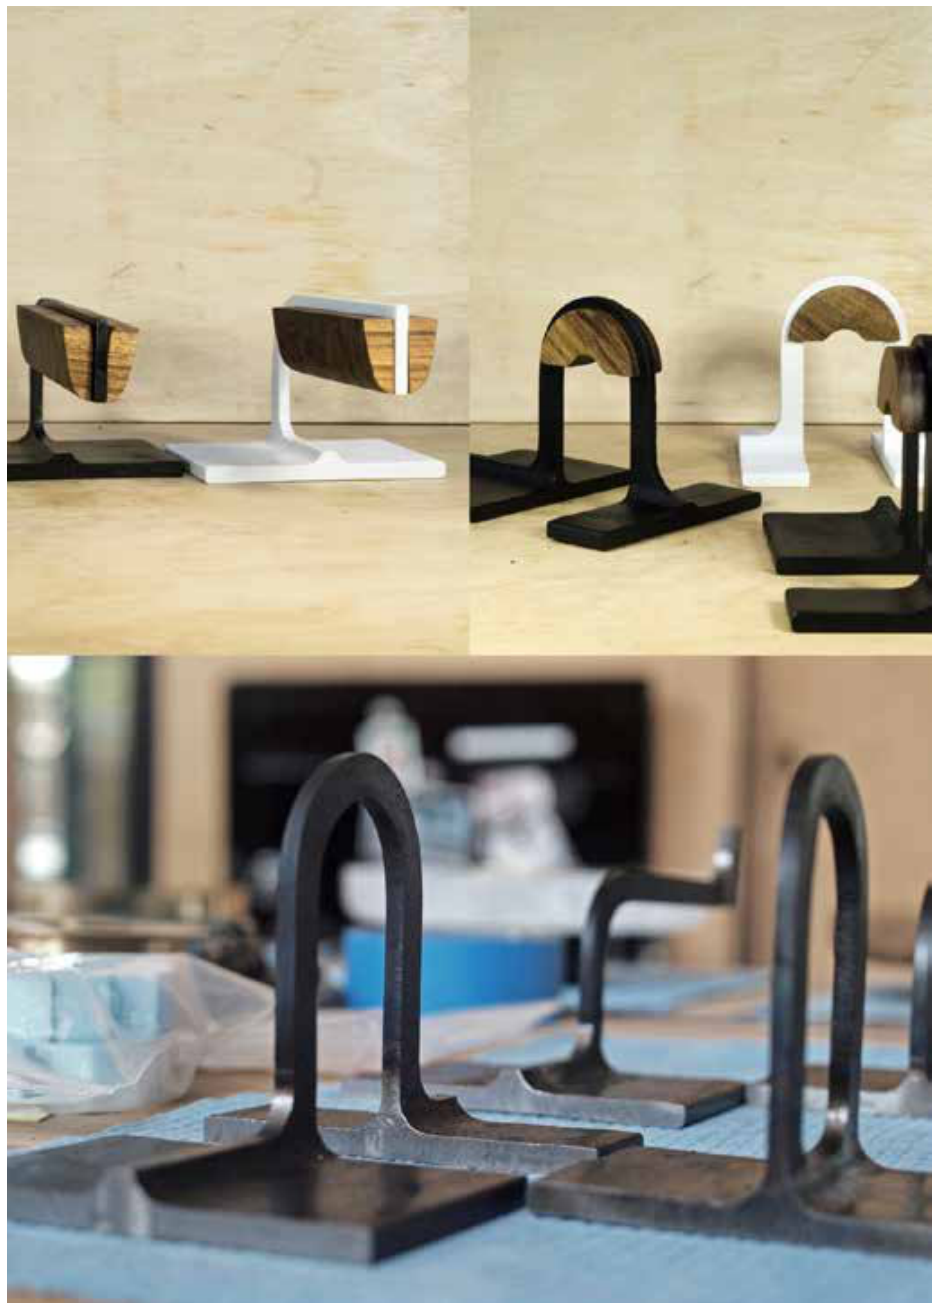
Figure 12: Fragments of architecture. Extensively milled wide flange beams result in delicate forms, belying their industrial origins. Discolouration shows heat-bending boundaries. Source: